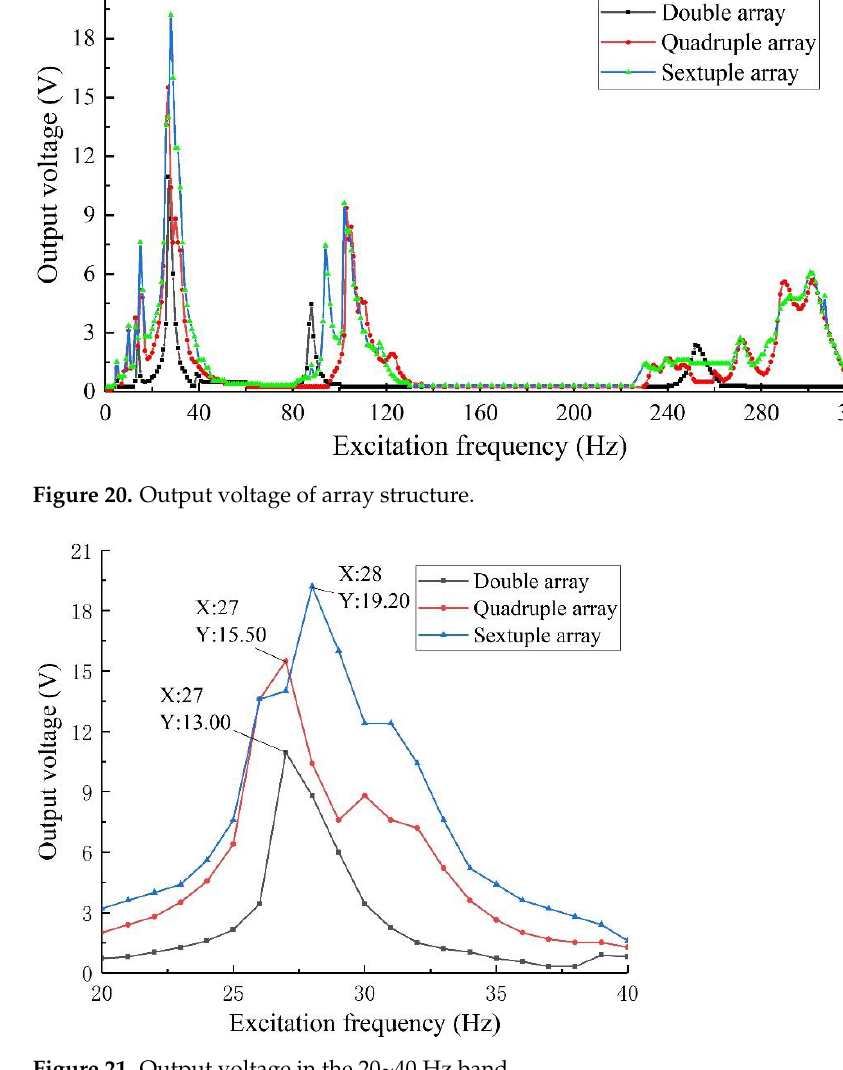
Figure 21. Output voltage in the 20~40 Hz band.